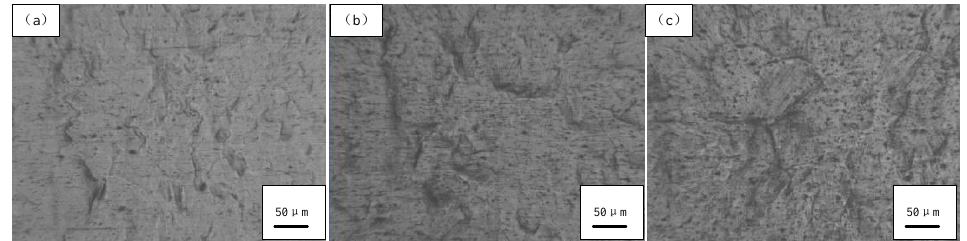
Figure 9. Surface morphology of stretched specimens with different strain variables: ( a ) 5%; ( b ) 6%; ( c ) 7%.